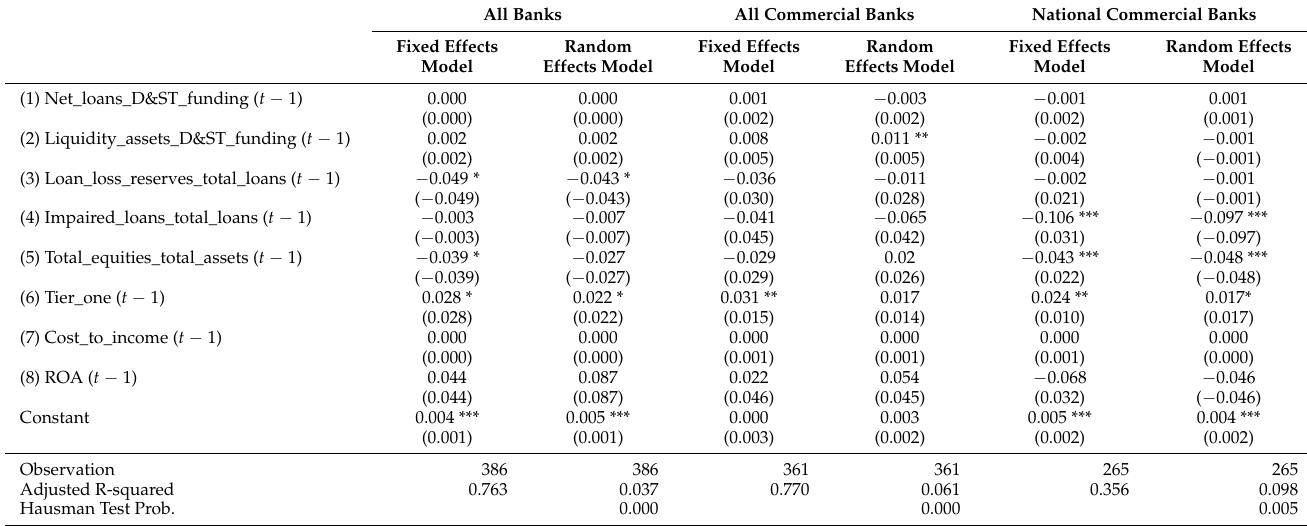
Table 12. Regression results of eight variables in t − 1